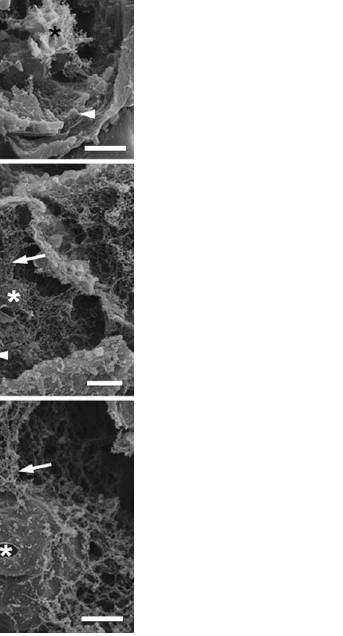
Figure 5. Alga cells treated with paclitaxel. (A) Control, (B,C) 0.12 mM paclitaxel. * = CC , arrow = cytoskeleton filaments, arro- wheads=vesicles. Few vesicles are observed dispersed in the cell periphery, in cytoskeletal filaments surrounding the CC or forming connections from the CC to the cell periphery. In cells treated with paclitaxel, note that larger connective structures were formed linking the CC to the cell walls. Bars=10 m m (A,B) and 2 m m (C). doi:10.1371/journal.pone.0063929.g005 (Tables 2 and 3). Among these genes, the expression of actin, tubulin and associated proteins, such as dynein light chain, tropomyosin 1, alpha-actinin, actin bundling proteins fimbrin/ plastin (Table 2), kinesin-like protein and myosin heavy chain (the latter two from not assembled sequences),was observed. With regard to vesicle traffic (Table 3), we confirmed the expression of genes related to vesicle budding, vesicle sorting and fusion, secretory activity and endocytic activity. In addition, we identified genes related to Golgi activity, transport from the ER to the Golgi complex and retrograde transport. Other related cell signalling transcripts were identified along with transcripts from the PI-3 kinase and Ca 2 + /CaM-dependent kinase families.